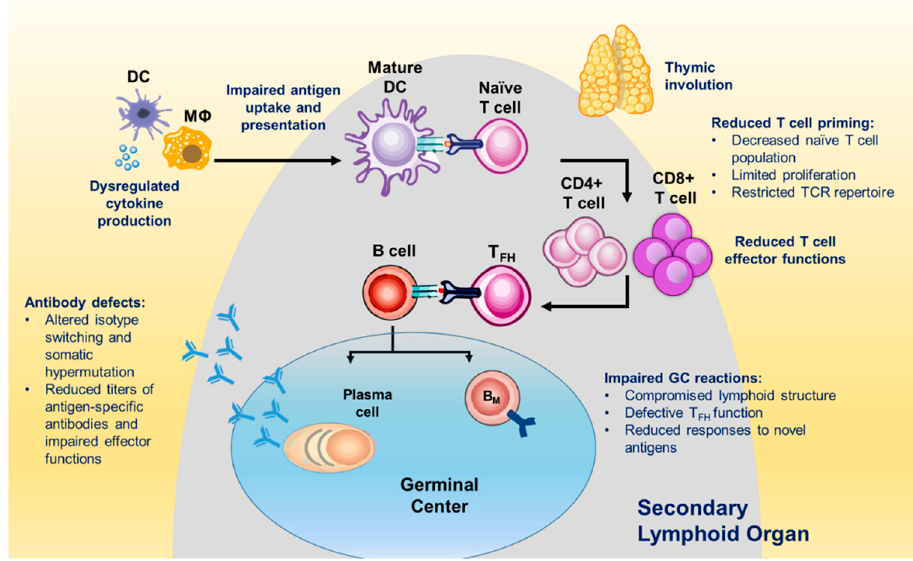
Figure 3. Overview of Age-Associated Impairments in the Immune System. Multiple compartments are affected by immunosenescence, including the innate and adaptive responses. Figure adapted from